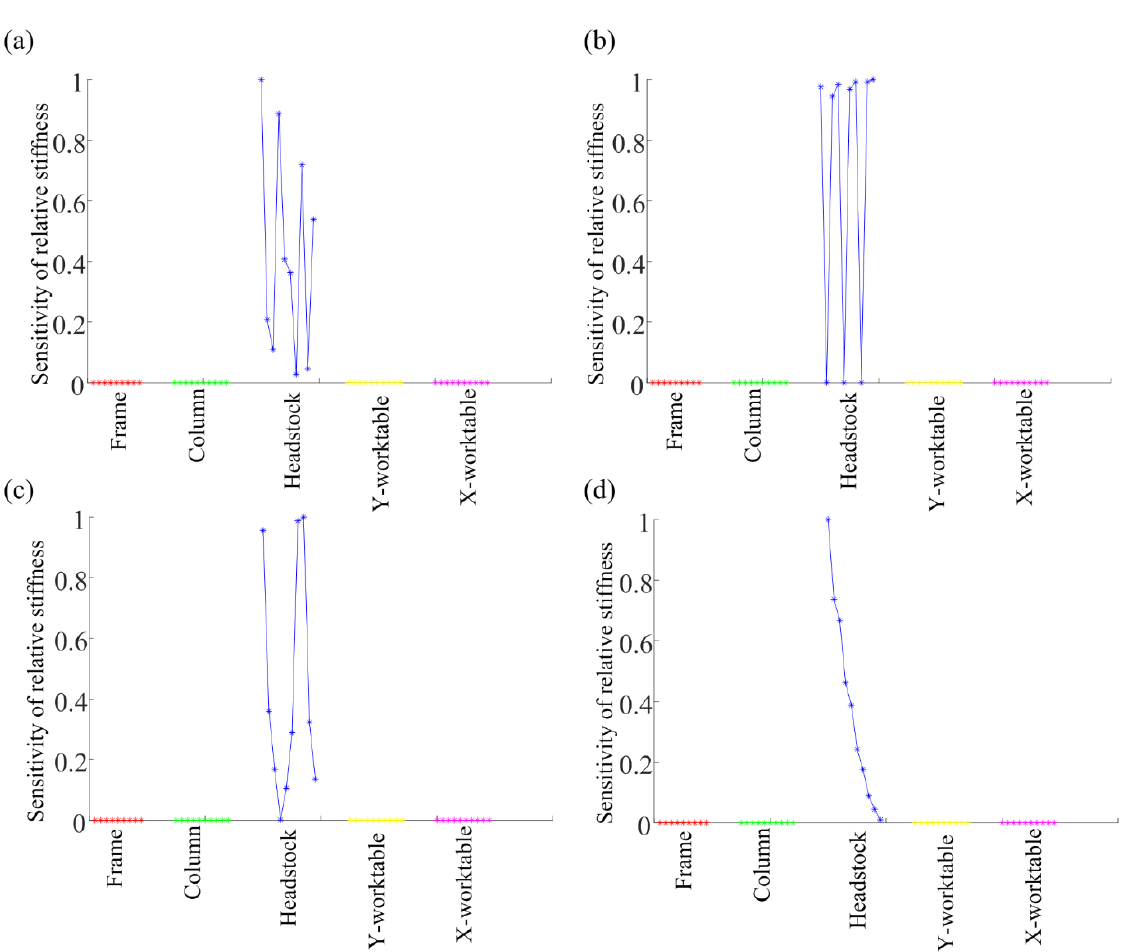
Figure 3. In case B, the modal dynamic stiffness sensitivity of each degree of freedom: ( a ) the first order ( b ) the second order ( c ) the third-order, and ( d ) the fourth order.